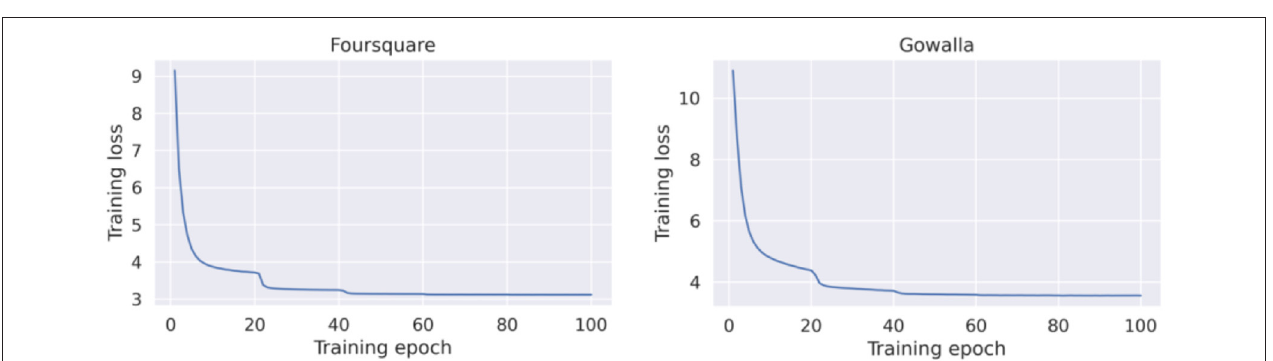
FIGURE 5 | Training loss of the centralized flashback model.